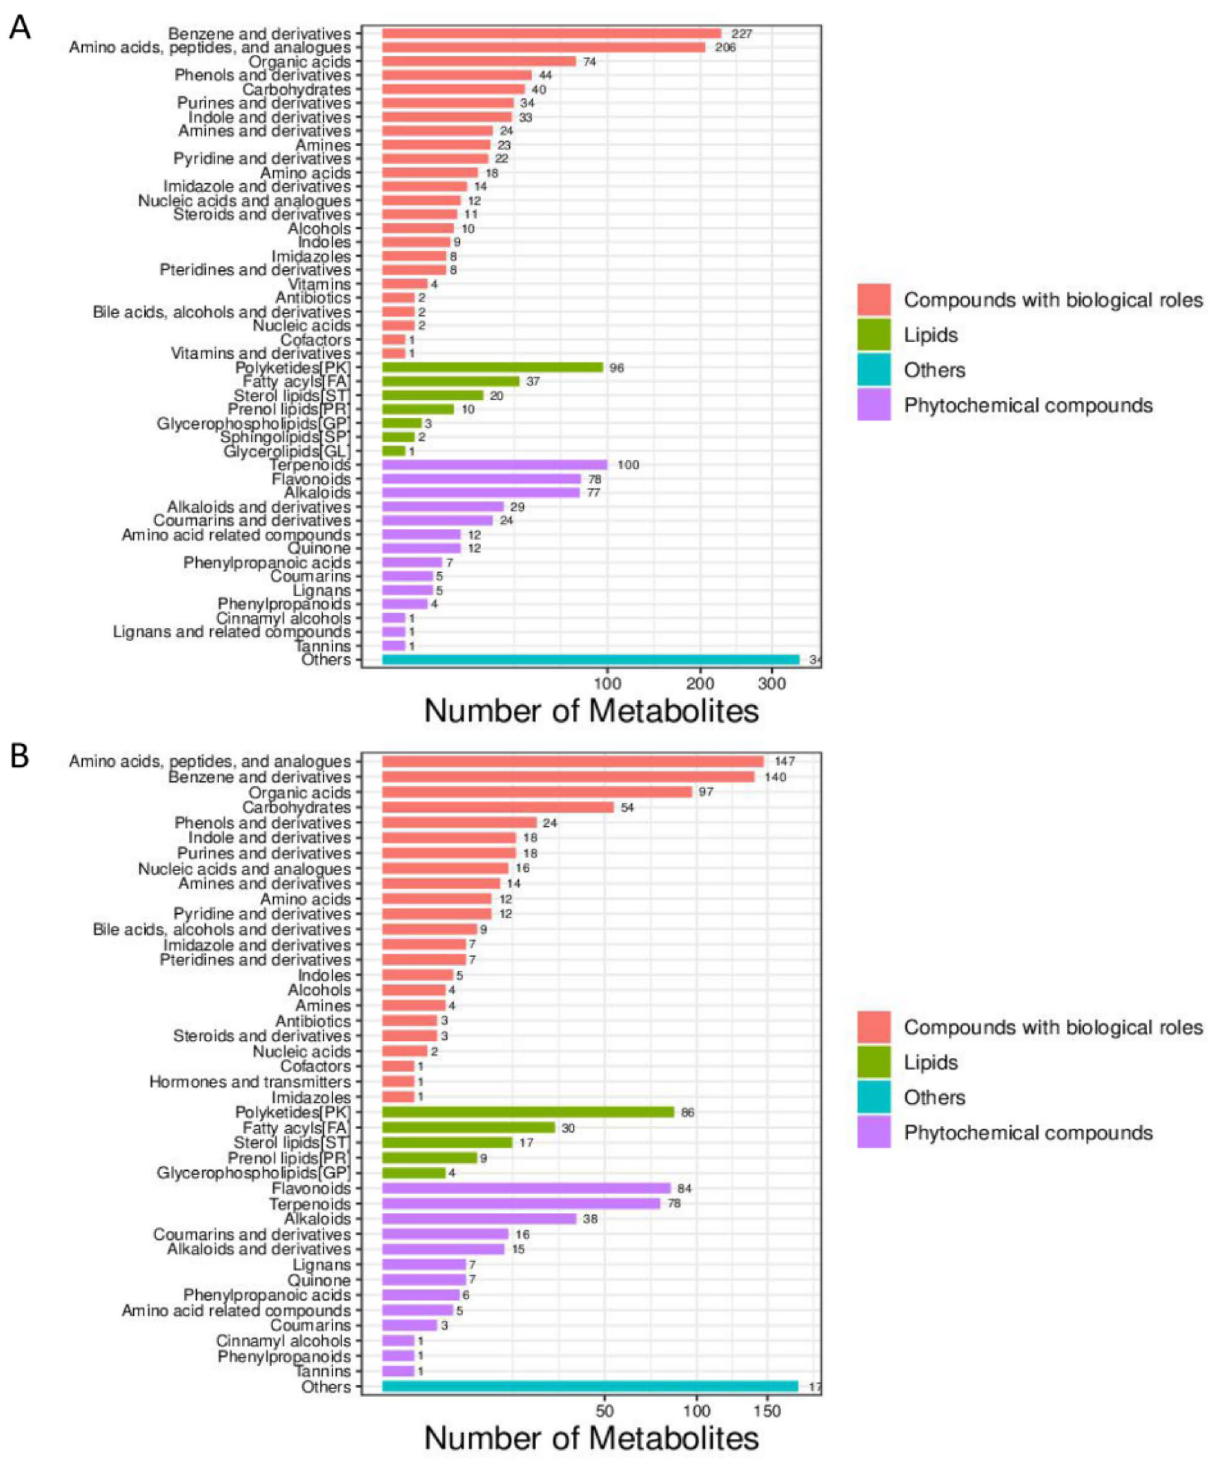
Figure 2. Metabolite classification in POS ( A ) and NEG ( B ) models. The identified metabolites were annotated with classification by reference to the KEGG and HMDB databases. The X axis represented the number of metabolite classifications, and the Y axis represented the metabolite classification items. Others meant that the classification information was the rest of the categories, and the identification results without the classification information were not included in the